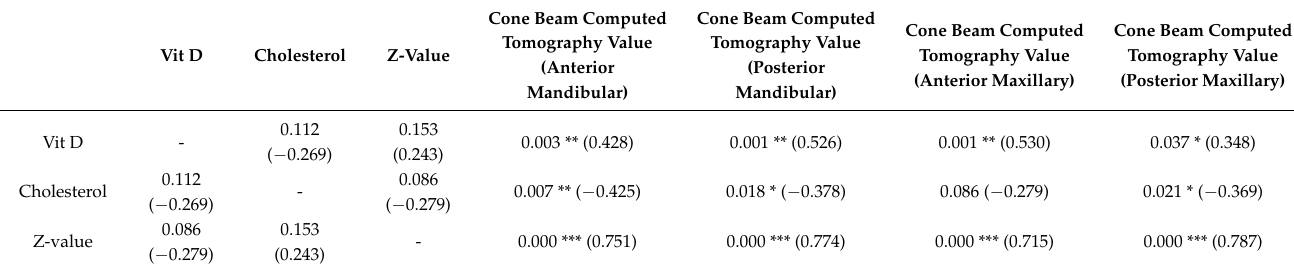
Table 5. Correlation analysis of parameters of the control group.